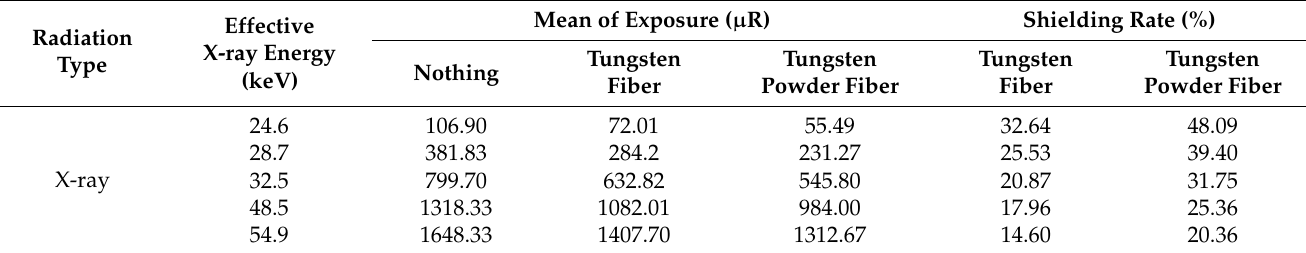
Table 2. Comparison of shielding rate of the two shielding